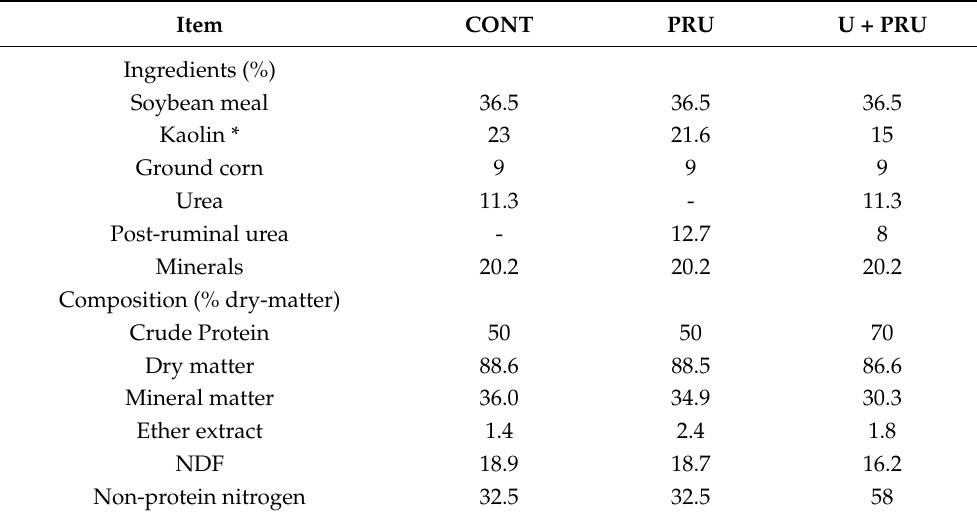
Table 1. Chemical composition of supplements used. Item CONT PRU U +